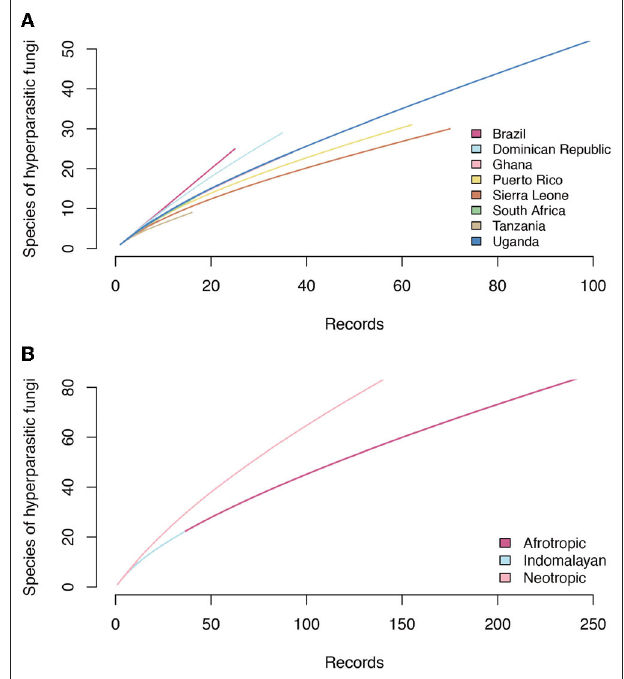
FIGURE 6 | Accumulation curves of hyperparasitic fungi in Meliolales in the Neotropics, Afrotropics, and Indomalayan ecoregions based on (A) increasing numbers of publications that were analyzed, and (B) on the number of hyperparasitic species known per countries based on increasing numbers of